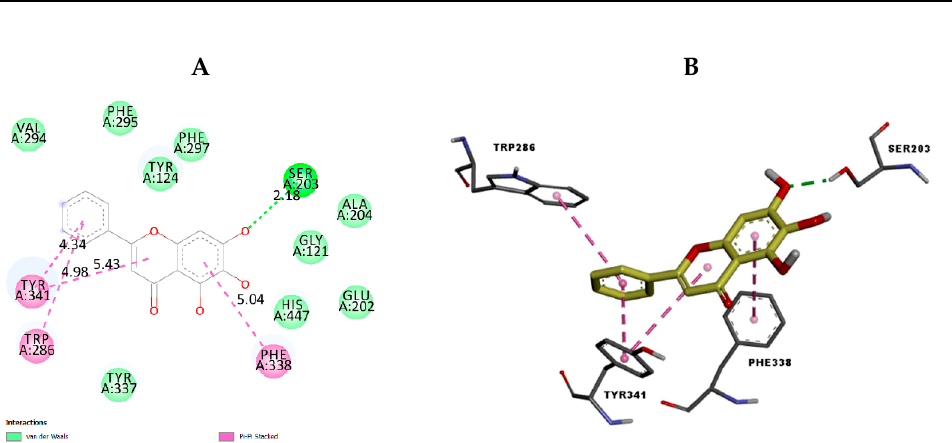
Figure 3. The 2D ( A ) view and 3D ( B ) view of the interaction type of M7 with the surrounding amino acids of acetylcholinesterase.